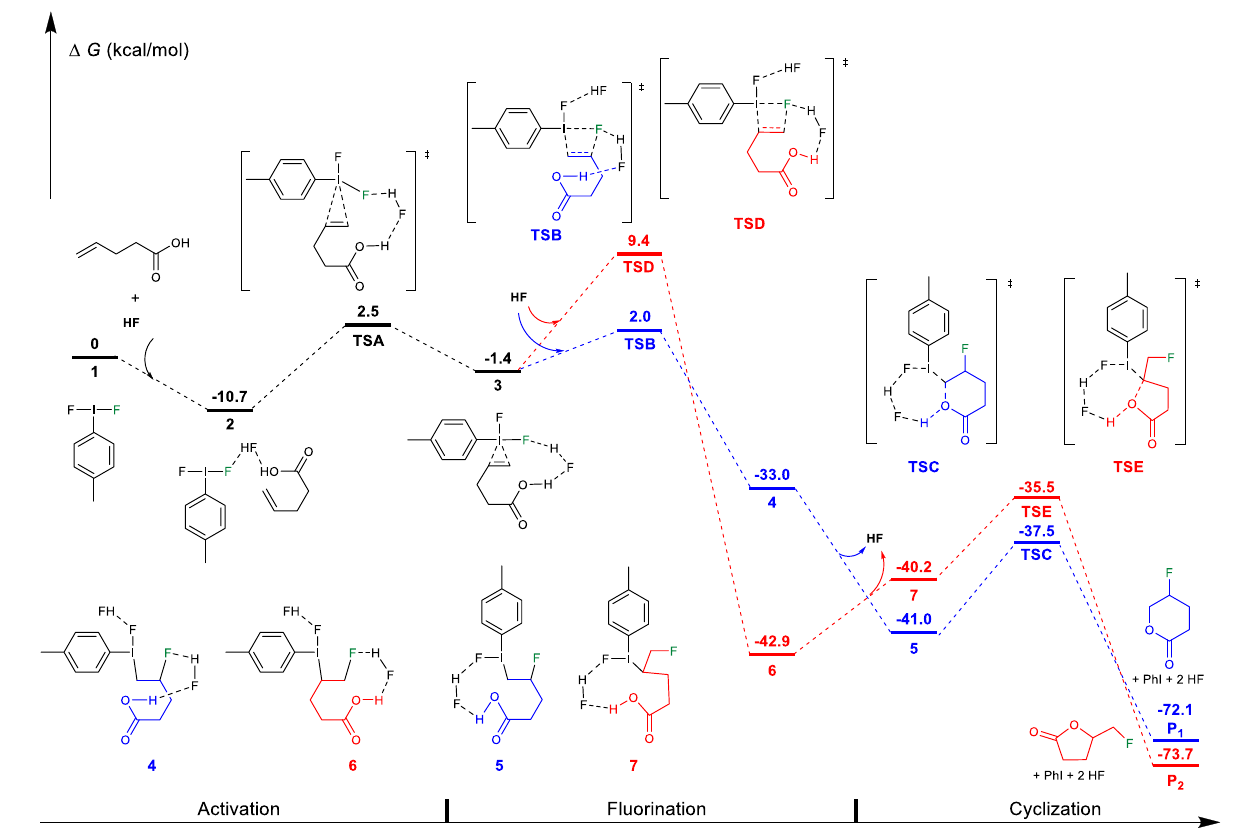
FIGURE 1 | Free-energy pro fi les for the fl uorocyclization of unsaturated carboxylic acid via the “ fl uorination fi rst and cyclization later ” mechanism. The preferred pathway is shown in blue.